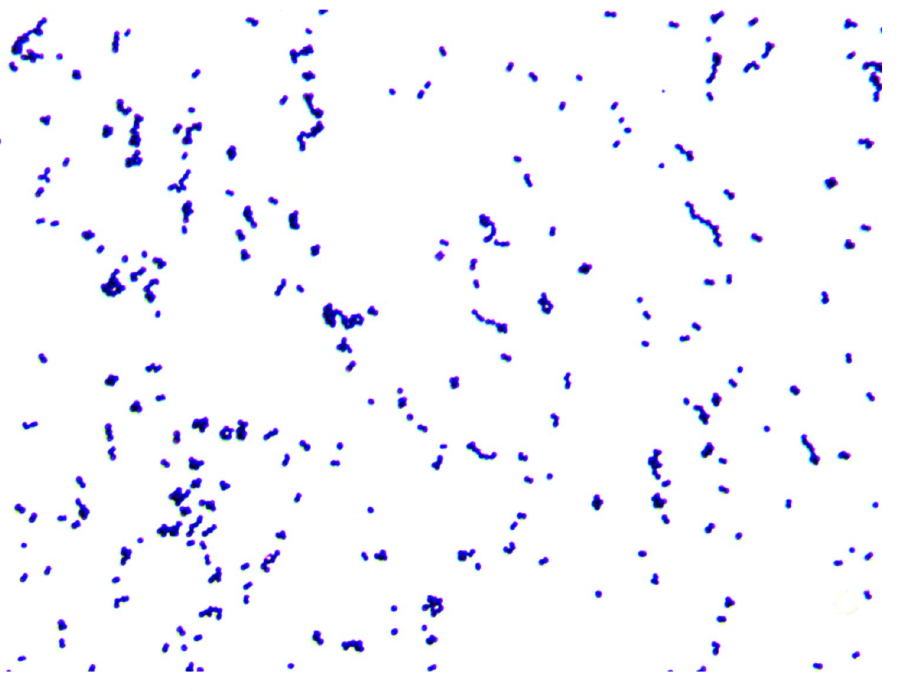
Fig 3. Gram staining of